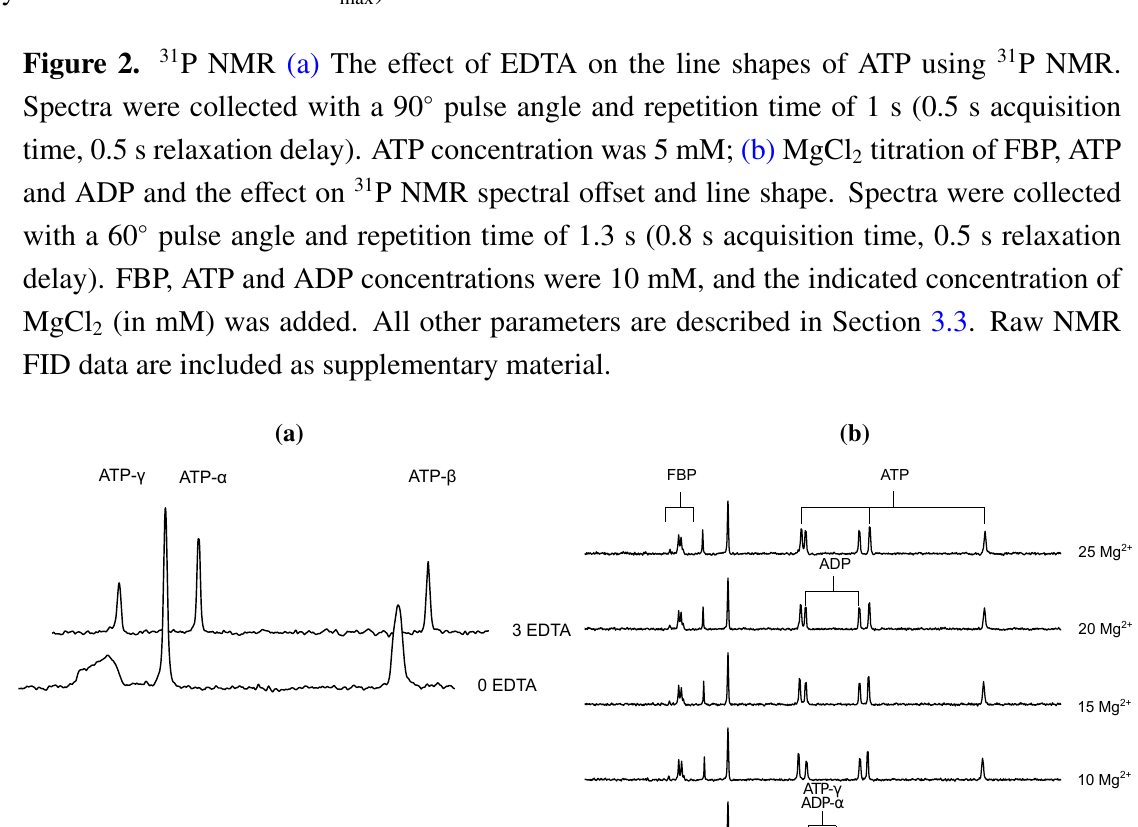
titration of FBP, ATP 2